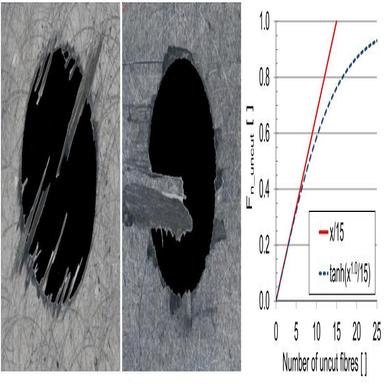
Bore exit in CFRP (Ø 6.35 mm) with numerous fine (left) and single wide uncut fibre bundle (middle) and plotted hyperbolic tangent for Fn (right) .